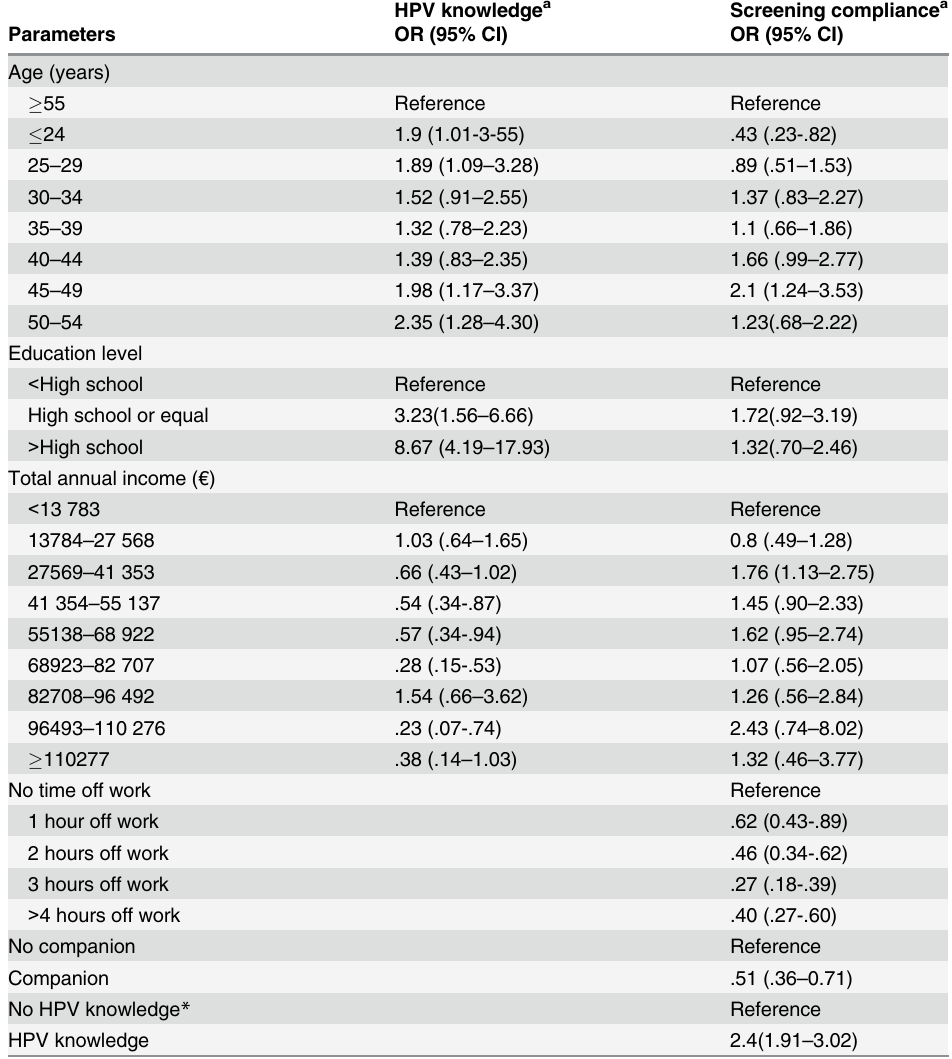
Table 6. Correlates of human papillomavirus (HPV) knowledge and screening compliance for 1510 women attending the clinic-based cervical cancer screening program in